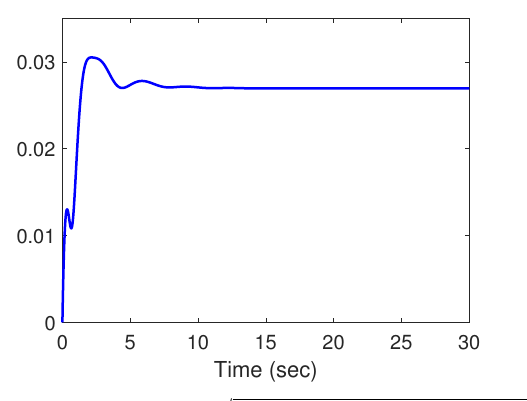
(cid:46) (cid:82) t r ν T ε ( t ) ν ε ( t ) dt 0